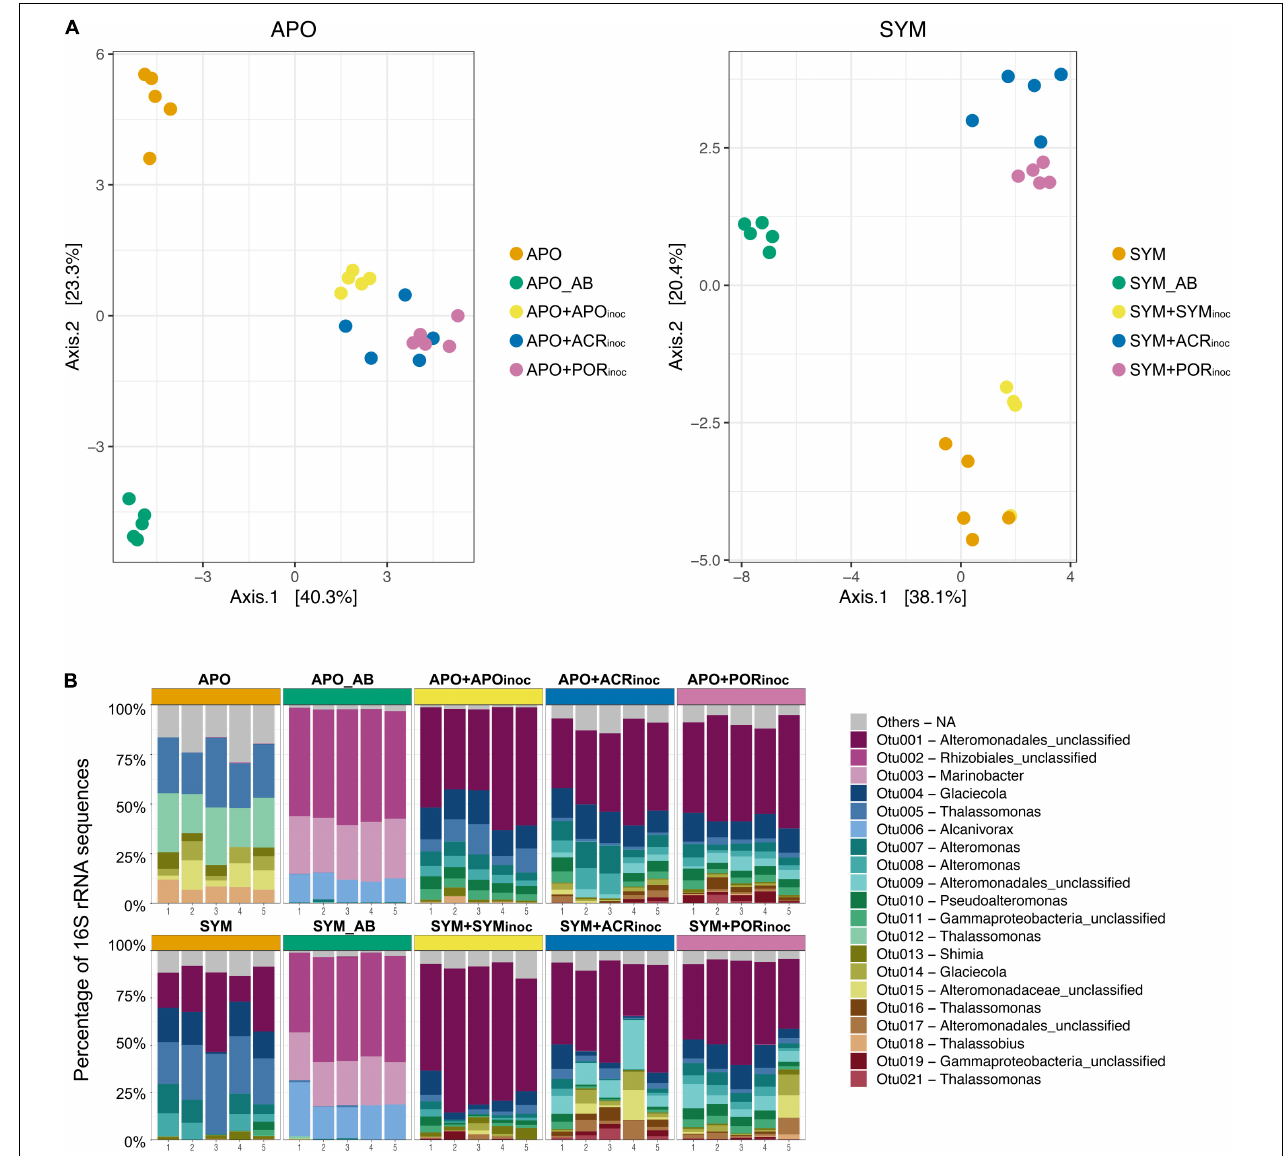
FIGURE 4 | Bacterial community composition and dynamics of Aiptasia polyps 7 days after microbiome transplantation. (A) Principal Coordinate Analysis (PCoA) based on Bray-Curtis distances of OTU log 10 (x + 1)-transformed abundances. (B) 16S rRNA amplicon-based active bacterial community composition at the OTU level. Depicted are the 20 most abundant (i.e., active) OTUs across all samples (refer to Figure 3A for an overview over time points sampled). Remaining OTUs are grouped as “Others.” APO/SYM, apo- and symbiotic control anemones; APO_AB/SYM_AB, 7-day antibiotic-treated anemones with a subsequent 1-day recovery; APO+APOinoc, APO microbiome inoculation after antibiotic treatment; SYM+SYMinoc, SYM microbiome inoculation after antibiotic treatment; APO/SYM+ACRinoc, Acropora humilis microbiome inoculation after antibiotic treatment (7 days after inoculation); APO/SYM+PORinoc, Porites sp. microbiome inoculation after antibiotic treatment (7 days after